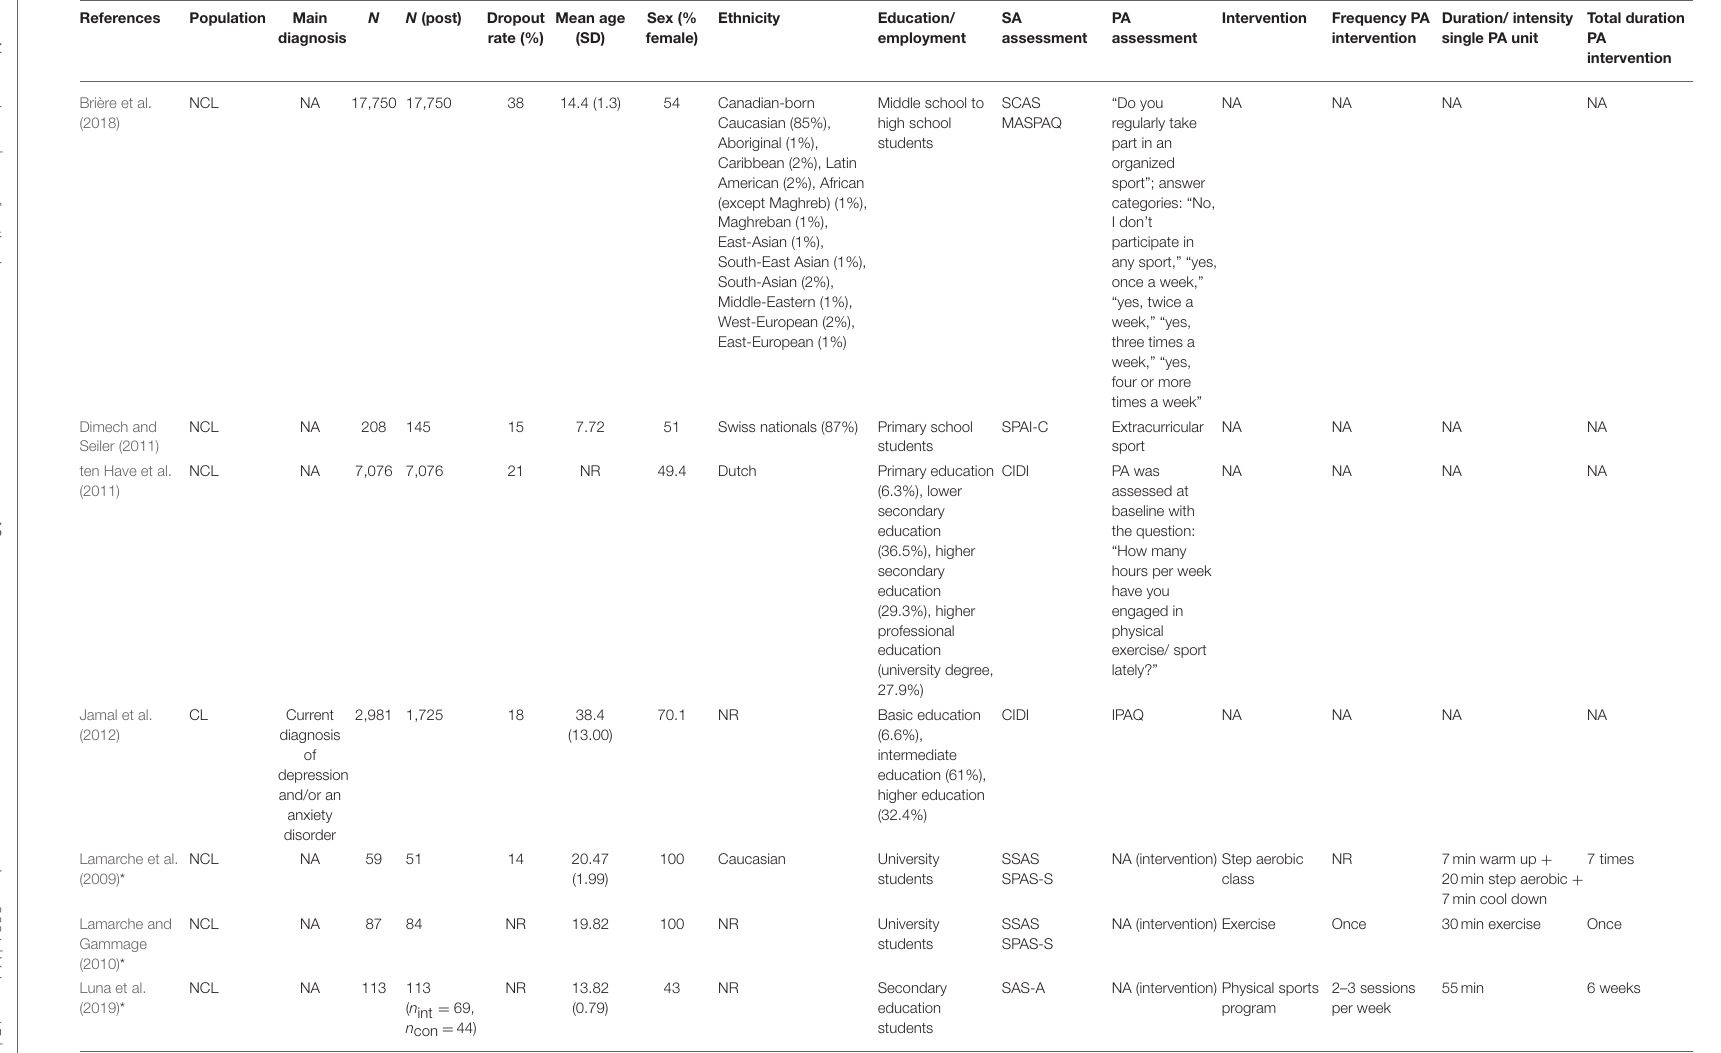
TABLE 2 | Characteristics of the studies with a longitudinal design and which were included in the